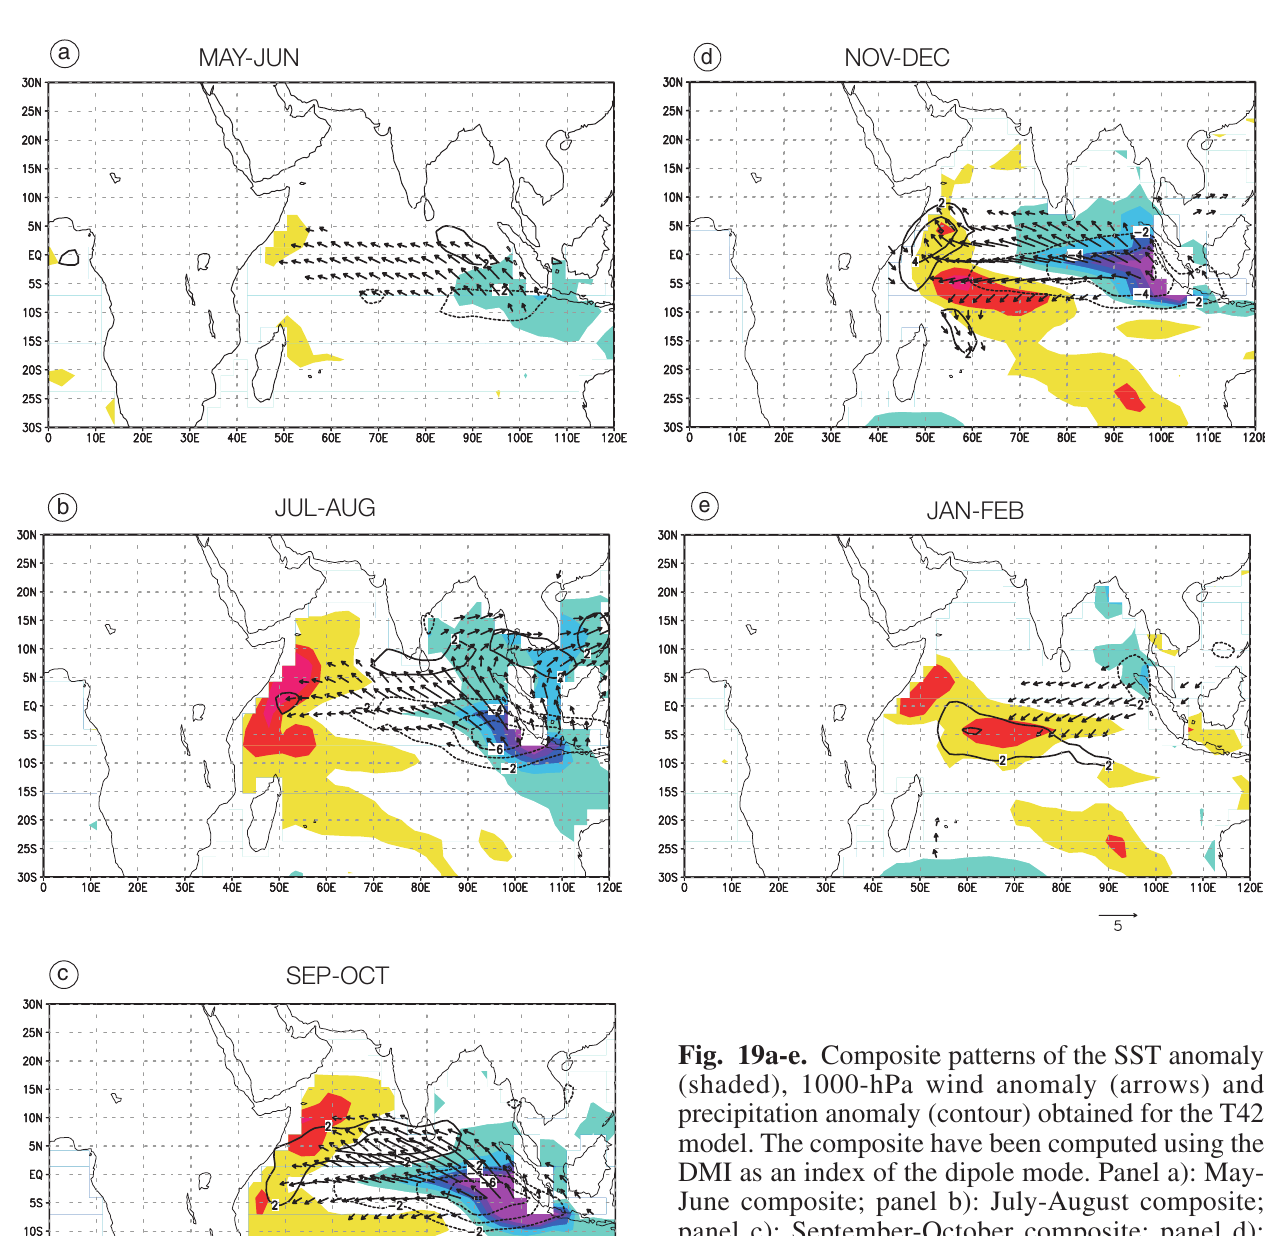
Fig. 19a-e. Composite patterns of the SST anomaly (shaded), 1000-hPa wind anomaly (arrows) and precipitation anomaly (contour) obtained for the T42 model. The composite have been computed using the DMI as an index of the dipole mode. Panel a): May- June composite; panel b): July-August composite; panel c): September-October composite; panel d): November-December composite; panel e): January- February composite. Shaded pattern interval is 0.2 ° C; blue colors indicate negative values, yellow-red colors indicate positive anomalies. Contour line interval is 2 mm/day; negative precipitation anomalies are represented with dashed lines. The reference arrow corresponds to a wind speed of 5